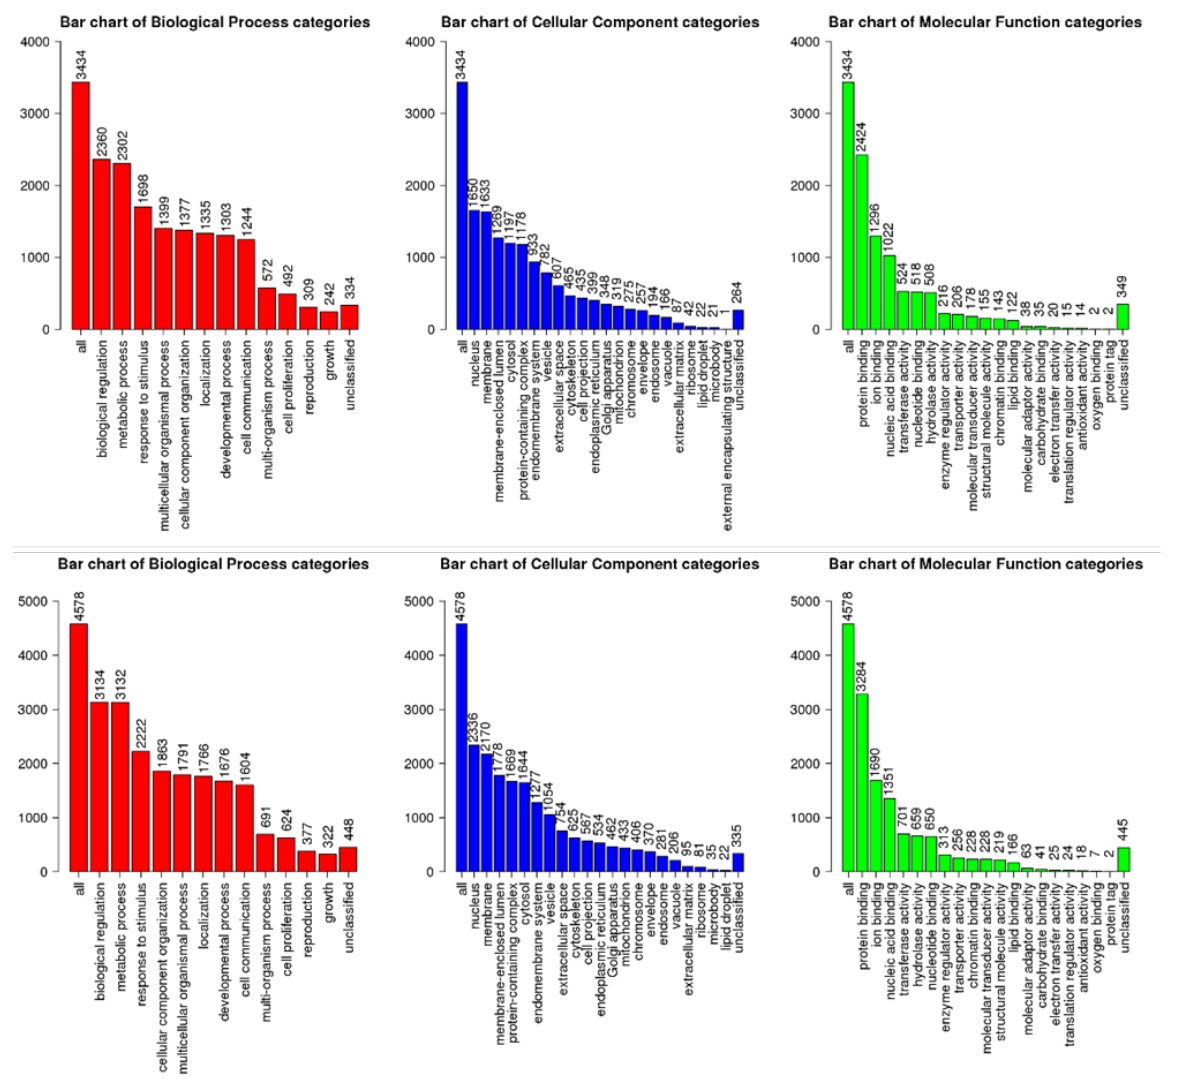
Figure 1. Gene ontology analysis of the target genes under the regulation of the miRNAs, showing differential expression in the TLDAs assay. Top comparison of proliferative diabetic retinopathy vs. idiopathic epiretinal membrane. Bottom: comparison of diabetic macular edema vs. idiopathic epiretinal membrane. Categories of biological processes in red, categories of cellular component in blue and categories of molecular function in green.